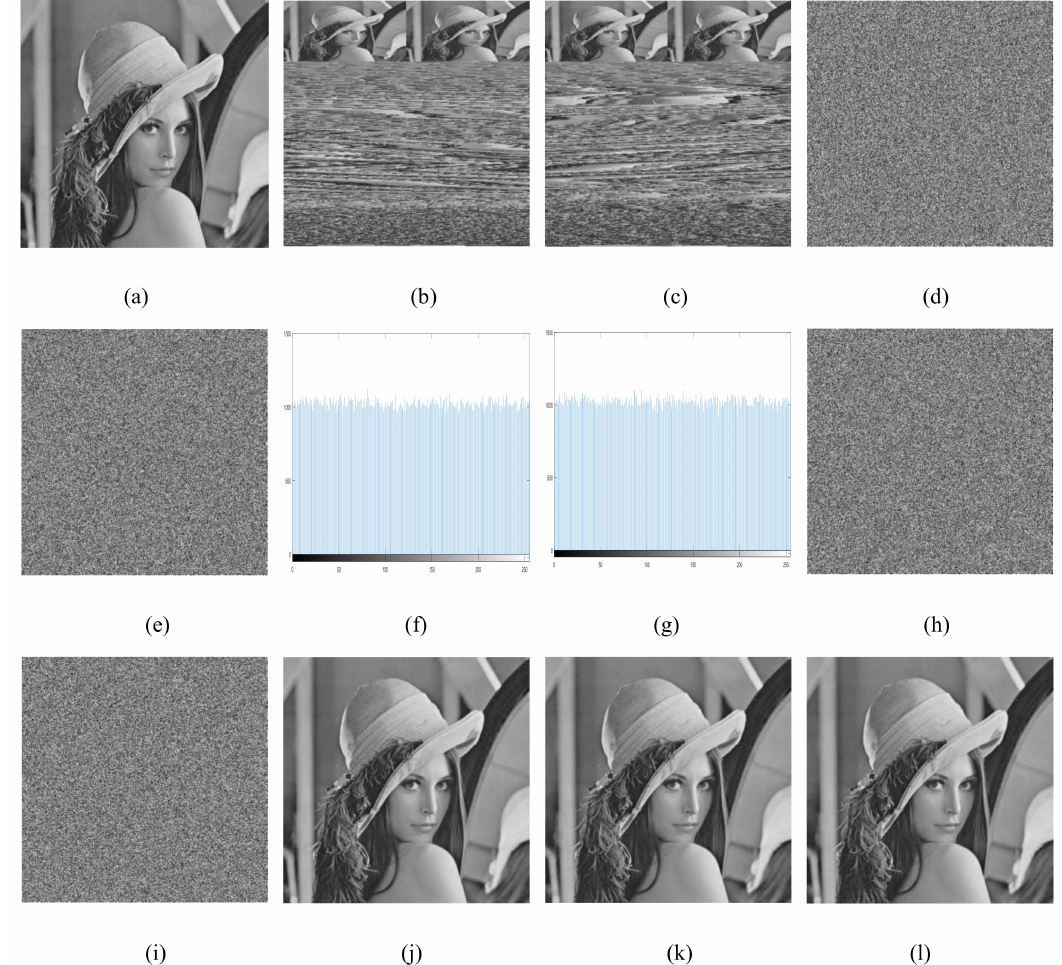
Figure 8. Experimental results for the proposed method. ( a ) Original image Lena. ( b ) Rearranged image with ( m , T ) = (7,5). ( c ) Rearranged image with ( m , T ) = (6,4). ( d ) The encrypted image of Figure 8b. ( e ) The encrypted image of Figure 8c. (f ) Histogram of Figure 8d. ( g ) Histogram of Figure 8e. ( h ) Marked image with 0.5 bpp. ( i ) Marked image with 0.9 bpp. ( j ) Reconstructed image under 0.5 bpp with only encryption key. ( k ) Reconstructed image under 0.9 bpp with only encryption key. ( l ) Reconstructed image with both encryption key and data-hiding